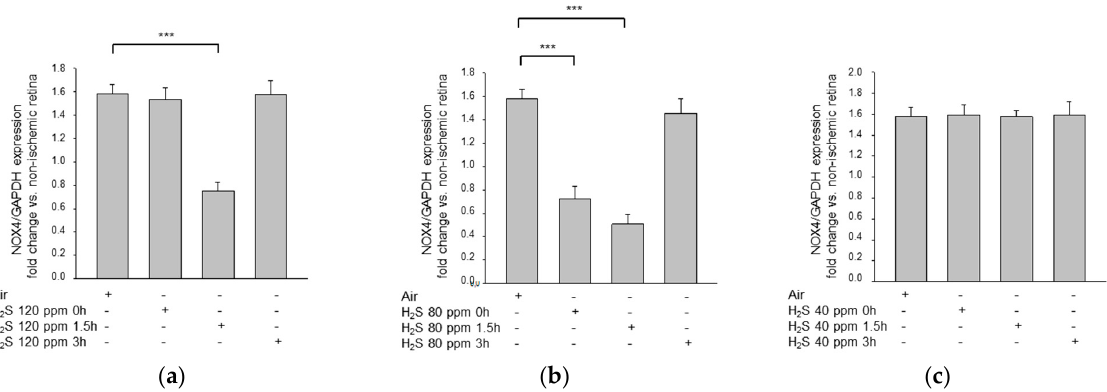
Figure 4 . Effect of H 2 S inhalation on retinal expression of NOX-4 mRNA. Fold induction of NOX-4 mRNA expression in ischemic retinal tissue compared to GAPDH in relation to the corresponding non-ischemic retinae analyzed by RT-PCR after ( a ) 120 ppm H 2 S inhalation (data are mean ± SD, n = 8; *** = p < 0.001, IRI vs. 120 ppm H 2 S at 1.5 h), ( b ) 80 ppm H 2 S inhalation (data are mean ± SD, n = 8; *** = p < 0.001, IRI vs. IRI + 80 ppm H 2 S at 0 h and vs. IRI + 80 ppm H 2 S at 1.5 h), and ( c ) 40 ppm H 2 S inhalation.